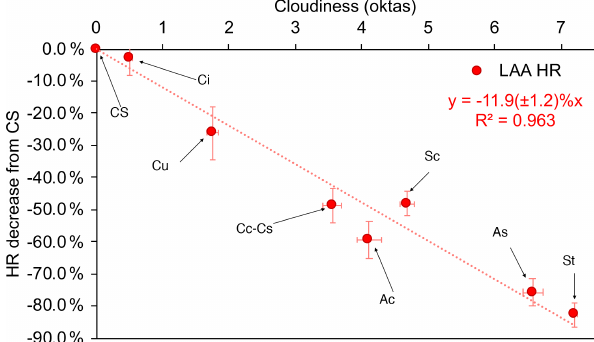
Figure 13. Percentage decrease of the HR with respect to clear-sky conditions as a function of the cloudiness (oktas) averaged for each cloud type.